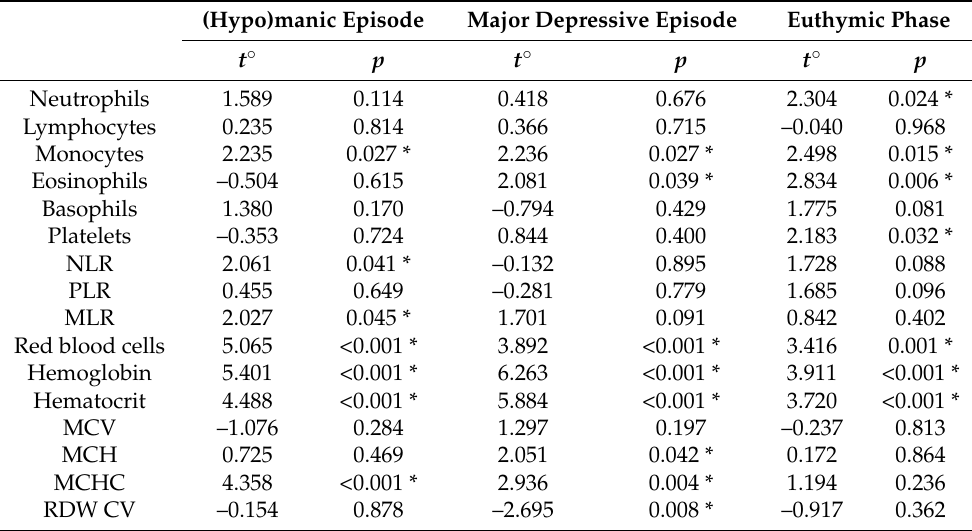
Table 4. Gender differences in cell blood count values during different bipolar illness phase.